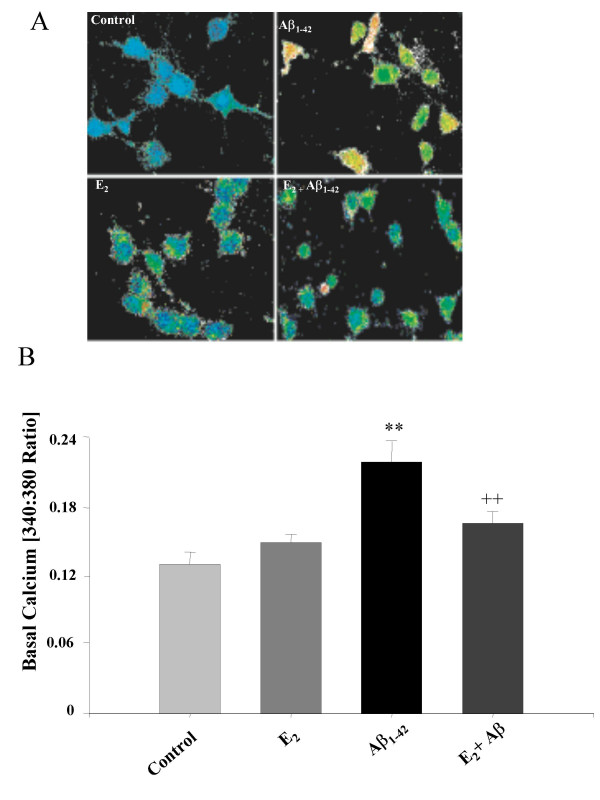
17β-estradiol prevents Amyloid beta1–42-induced rise in resting calcium concentration. Primary hippocampal neurons pretreated with E2 (10 ng/mL; 48 hr) or vehicle control were exposed to Aβ1–42 for 24 hr and assessed for cytosolic calcium concentration by Fura2 imaging. A. Representative images of Fura2 fluorescence in psuedocolor representing 340/380 ratio. B. Quantitative changes in Fura2 340/380 ratio presented as means +/- S.E.M. (** = p < 0.01 as compared to control; ++ = p < 0.01 as compared to Aβ1–42 alone; n = 4).